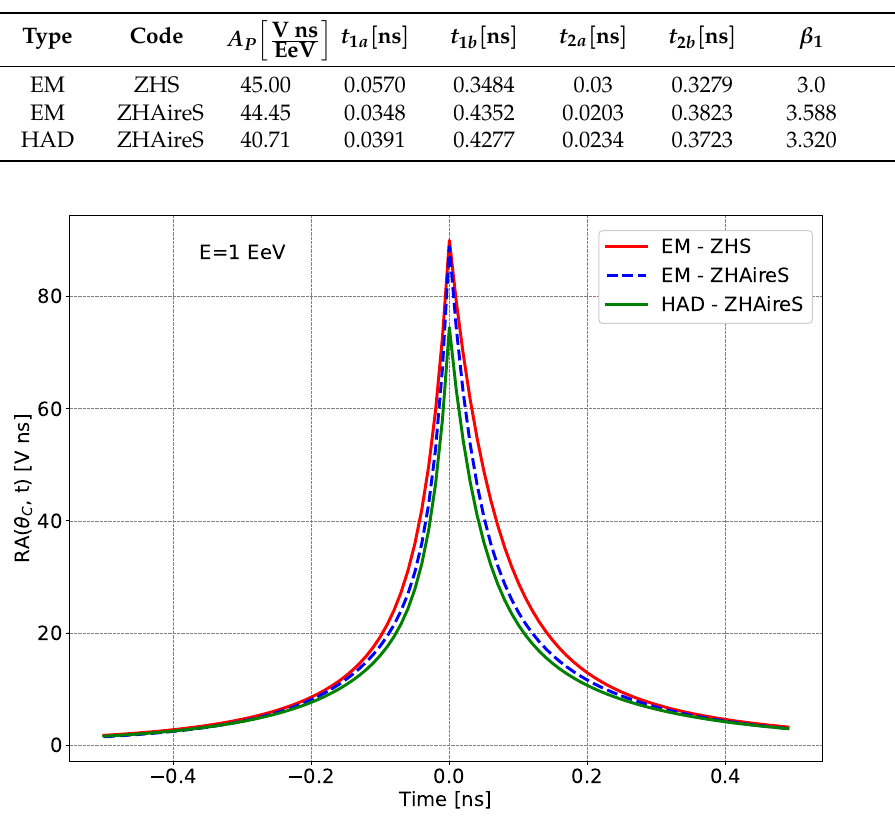
Figure 5. The vector potential at the Cherenkov angle (form factor) as given by the parameterization in Equation (25), with the parameters for two different types of showers (EM = Electromagnetic, HAD = Hadronic) and two Monte Carlo codes with which they were obtained (ZHS, ZHAireS) as given in Table